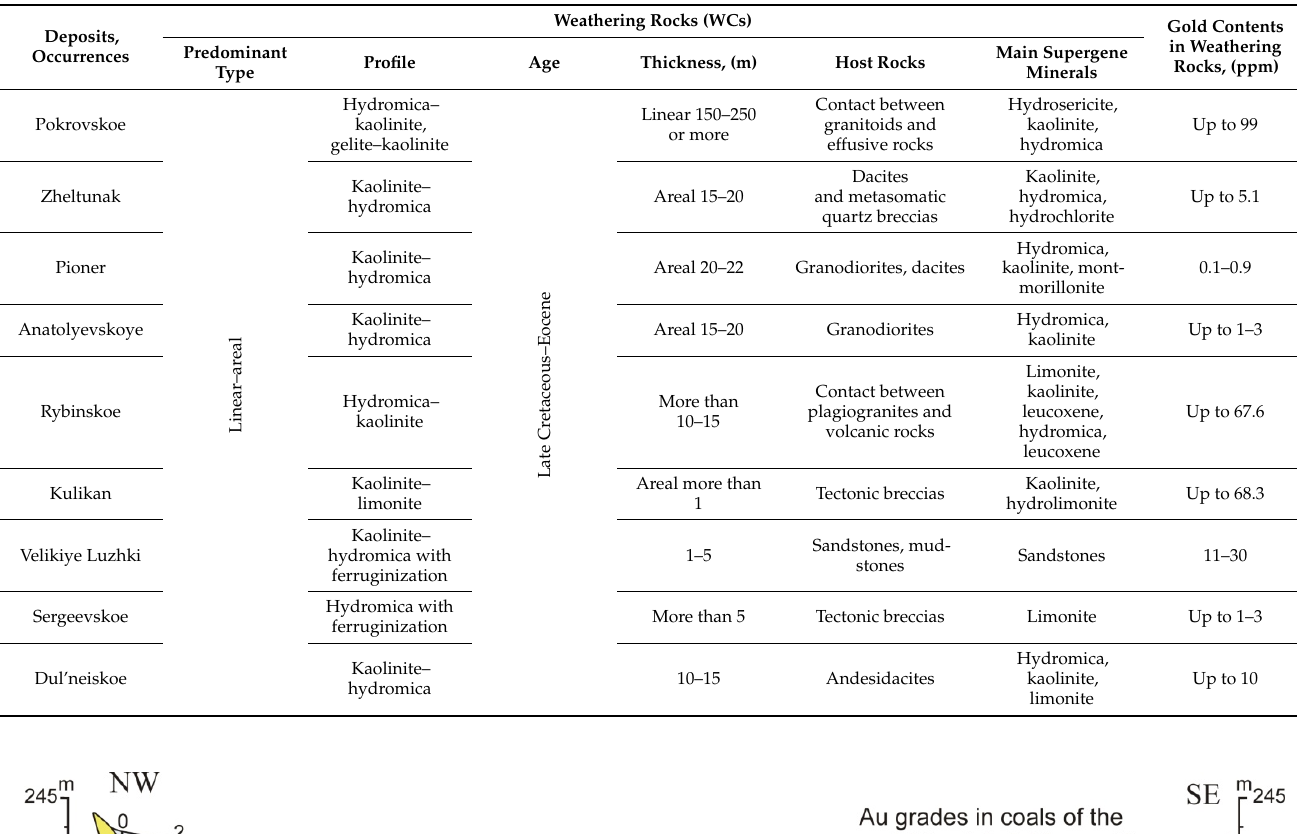
Table 2. Gold contents in weathering rocks of gold deposits and occurrences in the Tygda–Ulunginsky cluster of the Gonzhinsky gold district, modified from [28] and [30].